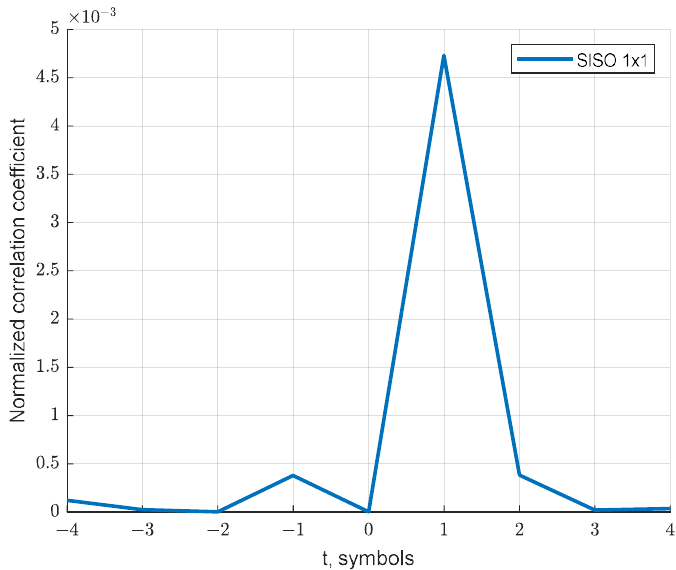
Figure 4. Normalized self-interference correlation coefficient versus time shift.